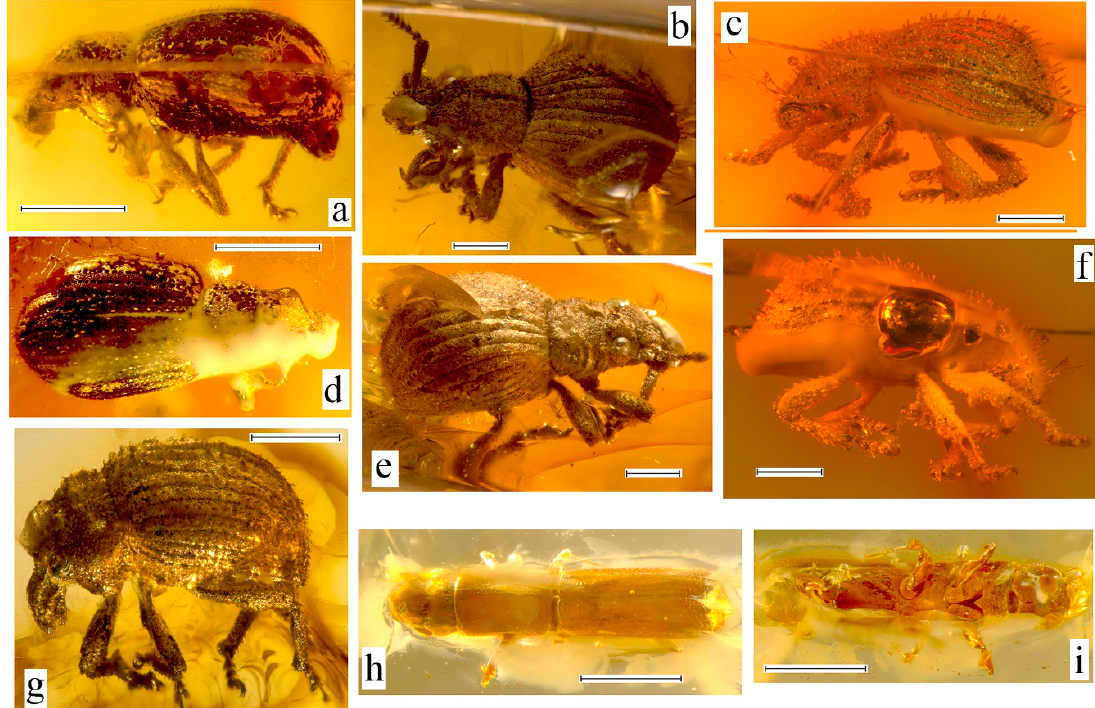
Figure 12. Habitus of Entiminae and Platypodidae from Baltic amber. ( a ) Polydrusus zherikhini sp. nov. , holotype, ISEA, BA2015 / 14, body, laterally. ( b , e ) Archaeocallirhopalus larssoni , holotype, ISEA, no. BA2012 / 1: body, dorsally ( b ); body, laterally ( e ). ( c , f ) Archaeosciaphilus marshalli , holotype, EIW, no. 7975: body, laterally, on the left ( c ); body, laterally, on the right ( f ). ( d ) Polydrusus zherikhini sp. nov. , holotype, ISEA, BA2015 / 14, body, laterally. ( g ) Archaeocallirhopalus alekseevi , paratype, ISEA, no. BA2012 / 13, body, laterally ( g ). ( h , i ) Cenocephalus aniskini sp. nov. , holotype, ISEA, no. BA2018 / 3: body, dorsally ( h ); body, ventrally ( i ). Scale bars: 1.0 mm. See Section 2 for names of collections.